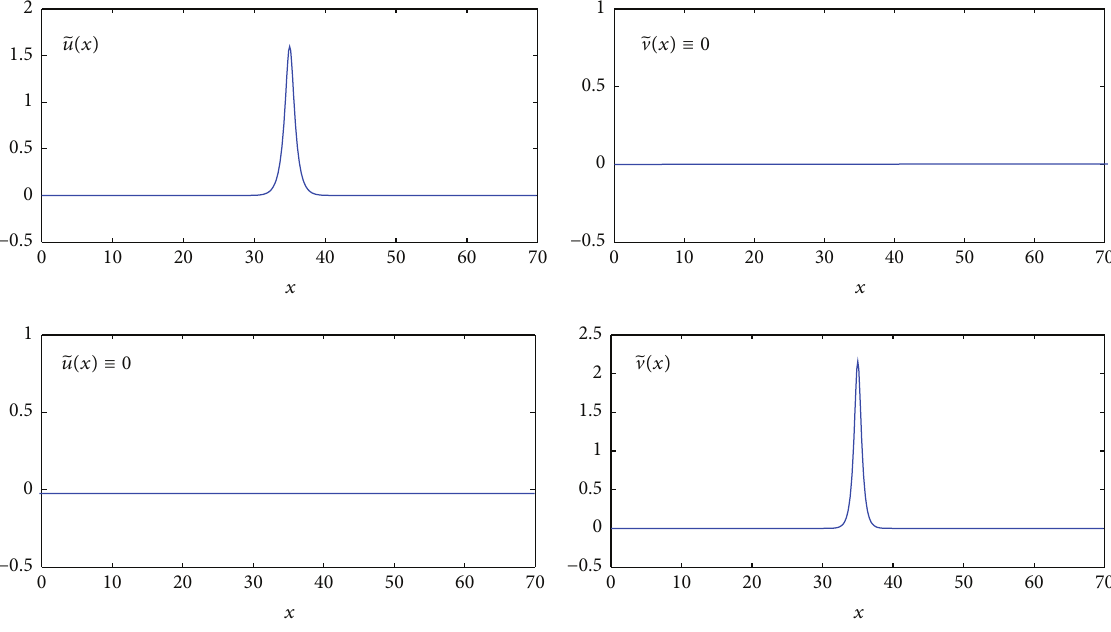
) , with 𝐴 = 1 (solid line), 𝐴 = 2 (pointed line), and 𝐴 = 4 (dashed line). 0